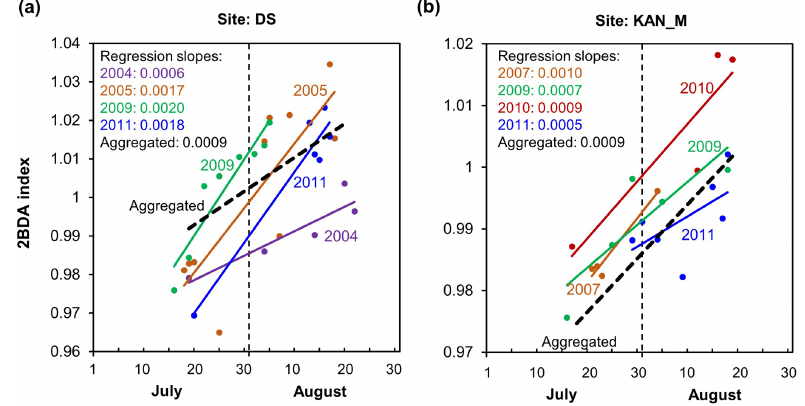
Figure A6. Temporal trends of 2BDA index from mid-July to Mid-August in different years at sites DS (a) and KAN_M (b)